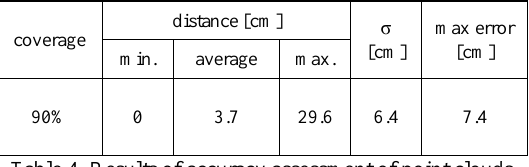
Table 4. Results of accuracy assessment of point clouds generated from video frames with a 90% overlap, with reference to a point cloud from NIKON D800 data The errors of the point cloud generated from video data